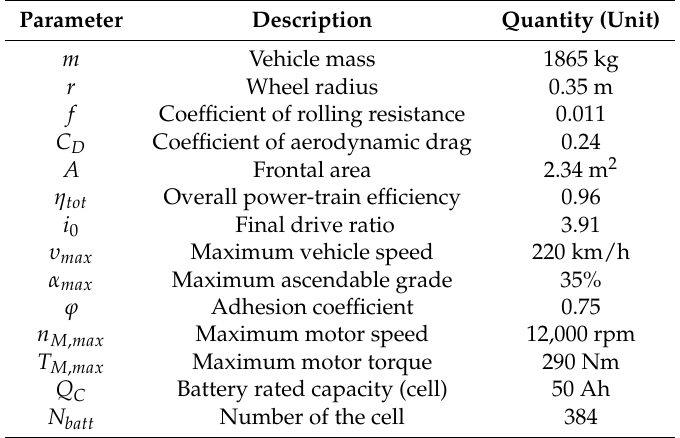
Table 2. Vehicle and component